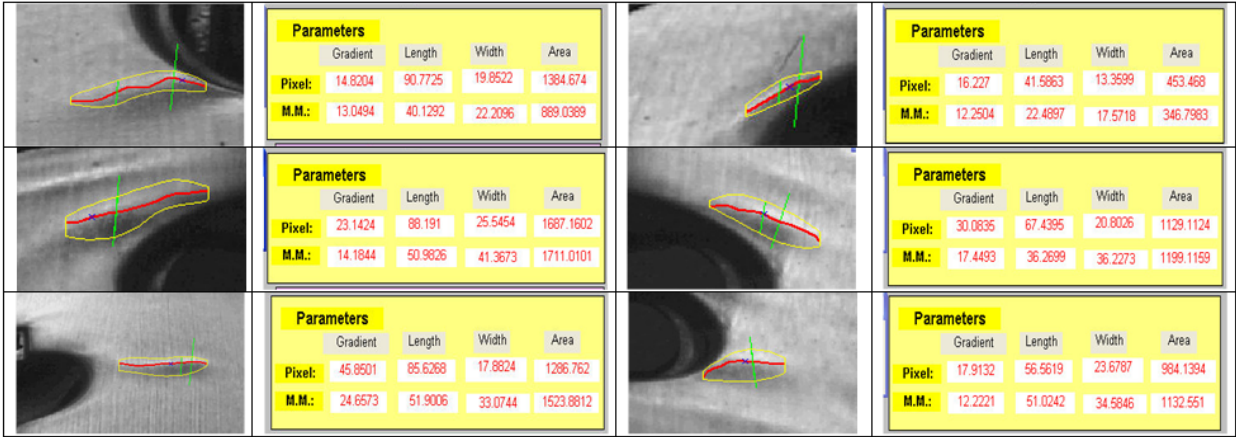
Figure 10. Evaluation of different imperfections.